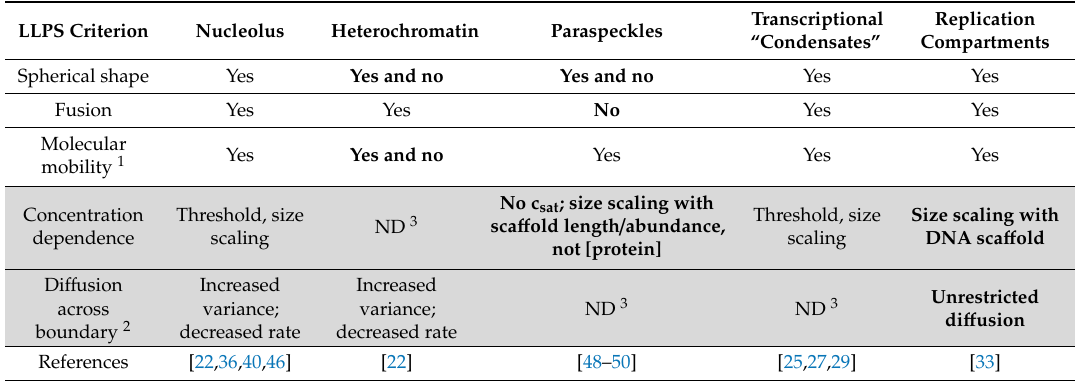
Table 1. Additional criteria are necessary for identifying liquid-liquid phase separation